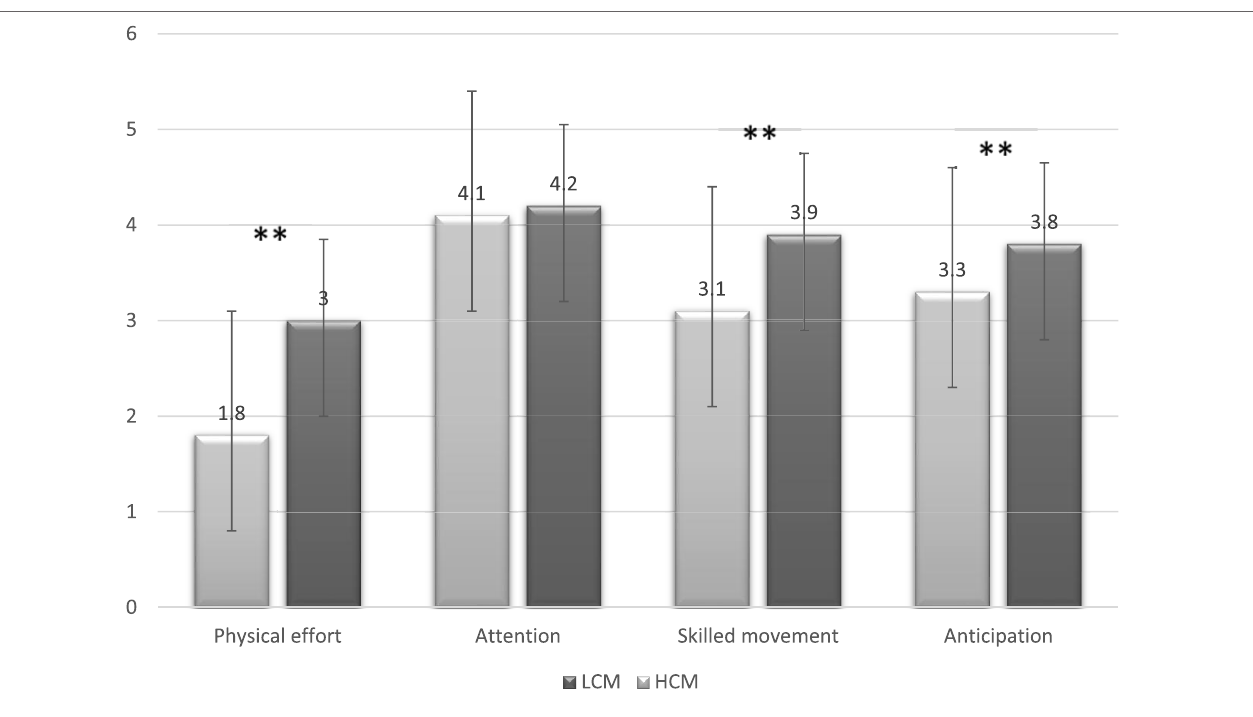
FigUre 1 | Self-Feedback virtual reality inventory (mean ± SD) (scale 1–5; 1: not at all and 5: very